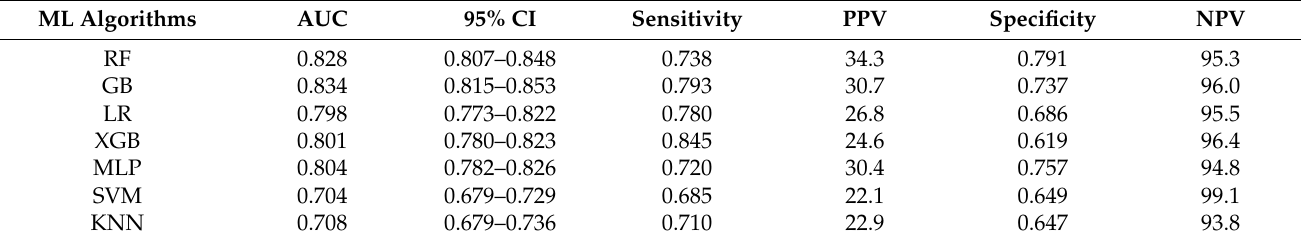
Table 2. Performance of machine learning models in the test set.